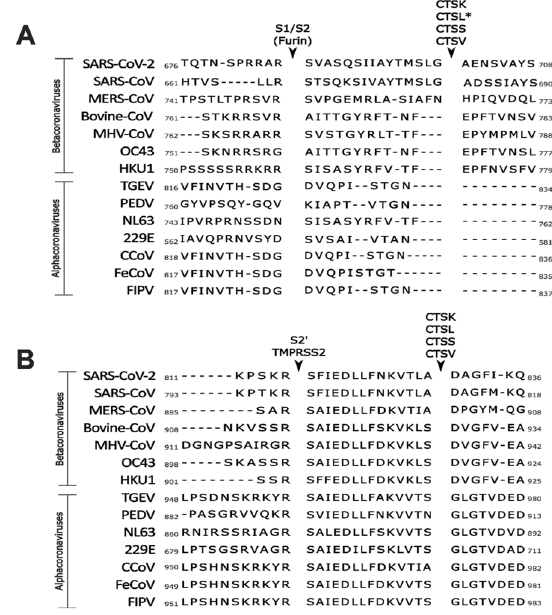
Fig. 2 PACMAN prediction of SARS‑CoV‑2 cathepsin cleavage sites. A PACMAN predicted cleavage site of SARS‑CoV‑2 near S1/S2 and S2’ by cathepsins K, L, S and V aligned with other coronaviruses of importance. *Cathepsin L has also been predicted to cleave at this site in studies of MERS‑CoV S. B Predicted cleavage site of the cathepsins near the S2’ cleavage